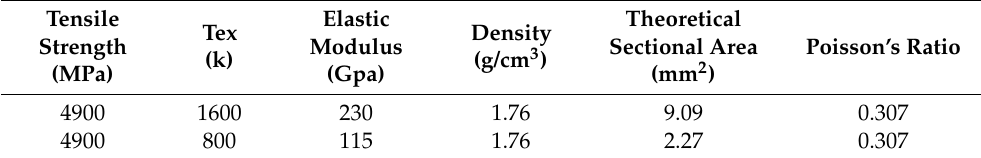
Table 2. Mechanical parameters of carbon fiber